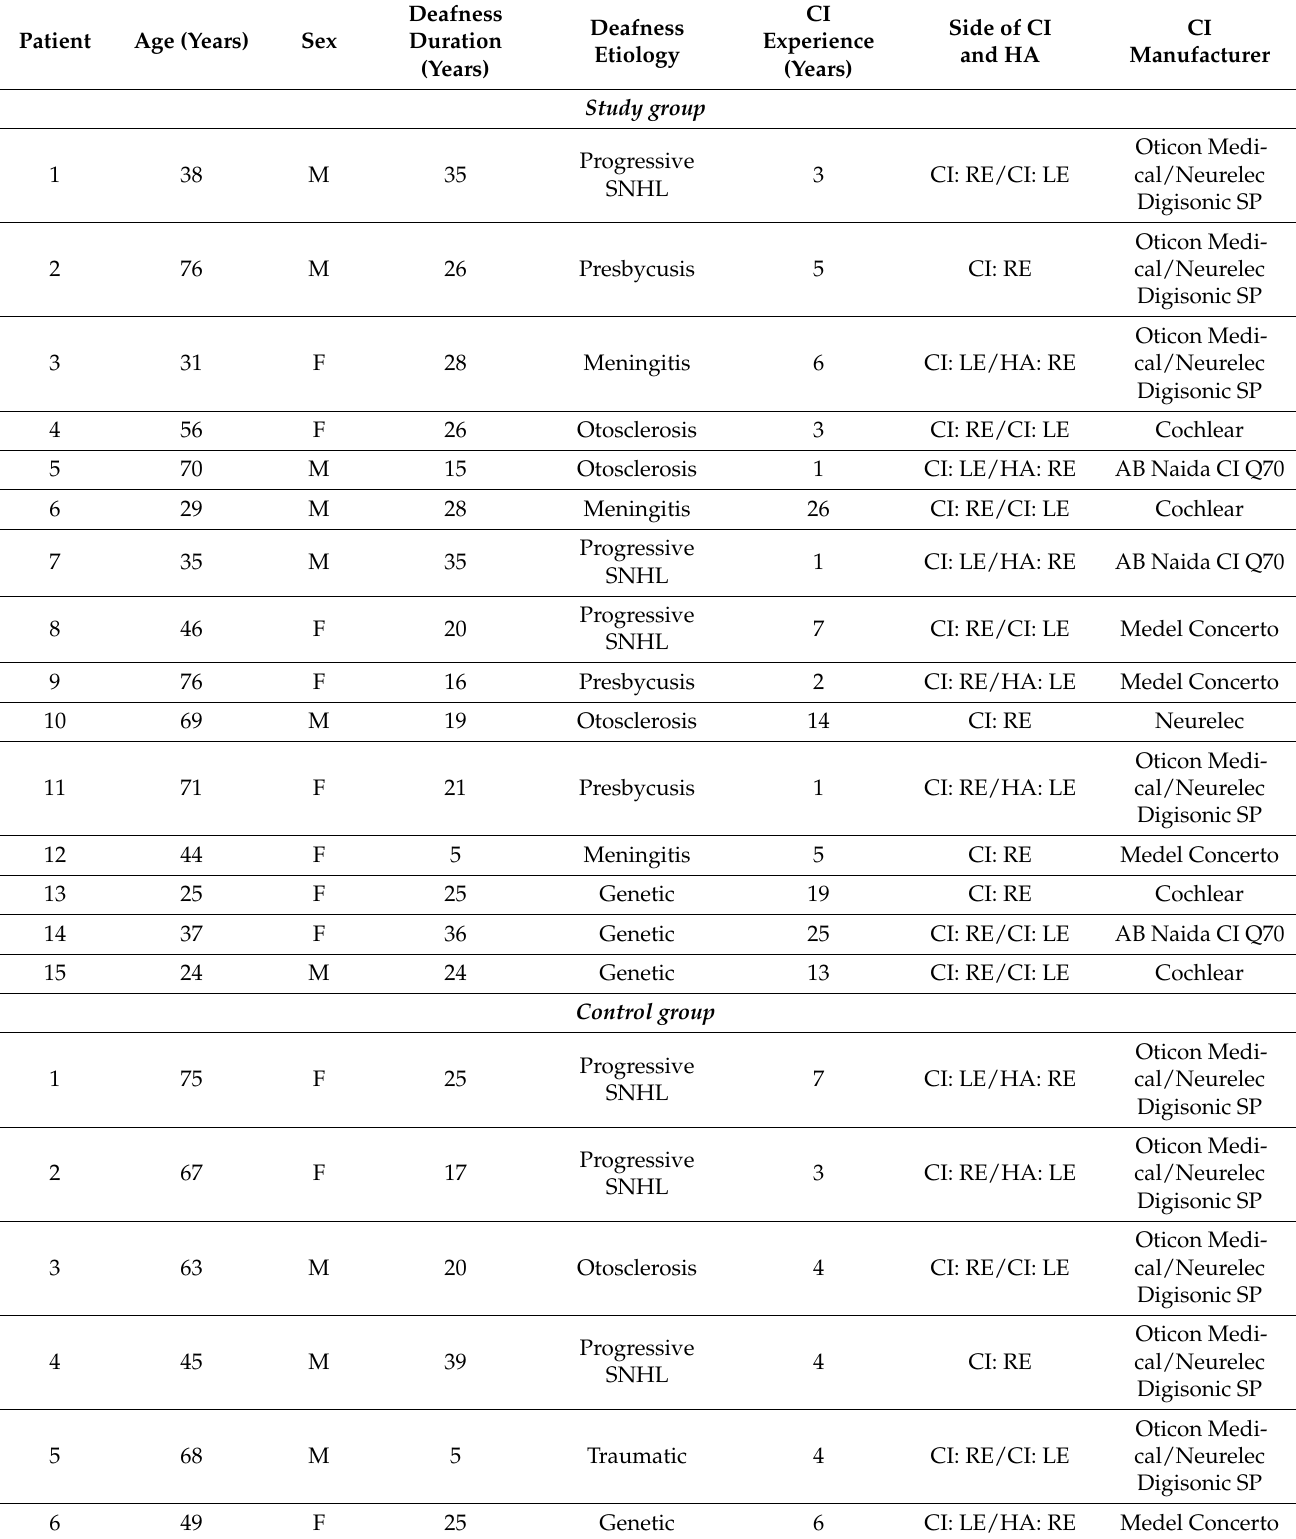
Demographic data for trained and untrained participants (CI = cochlear implant; HA = hearing aid; RE = right ear; LE = left ear; SNHL = sensori-neural hearing